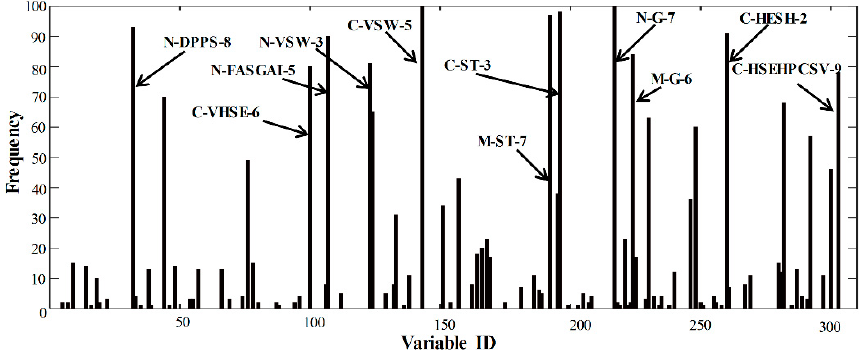
Figure 2. Frequency of variables selected by the bootstrapping soft shrinkage (BOSS) method on the FTC dataset in 100 runs. The higher frequency denotes higher variable importance. The top 11 variables with frequency larger than 75 were marked in the figure.